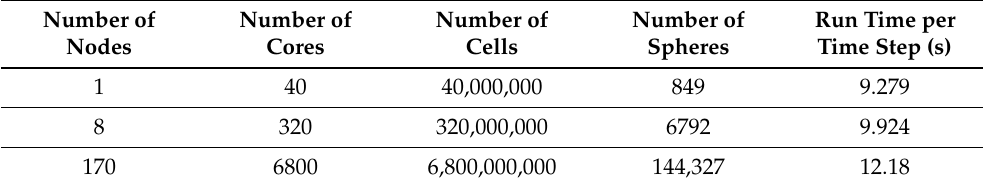
Figure 27. ( a ) Computational domain showing all rigid spheres. ( b ) Sub-domain on a single comput- ing core showing well-resolved spheres with a grid resolution of 24 grid points per diameter. Table 2. Weak scaling results in the flow through a random array of spheres at Re = 19.2 and φ =